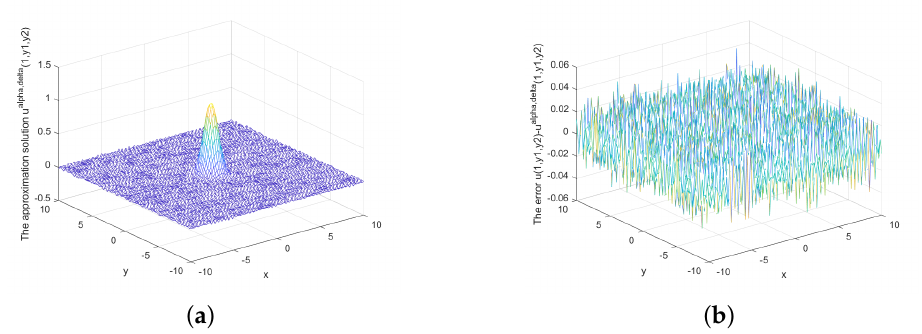
Figure 6. ( a ) The exact solution and ( b ) the regularized solution when x = 0.2, δ = 1 × 10 − 2 under the posterior rule.